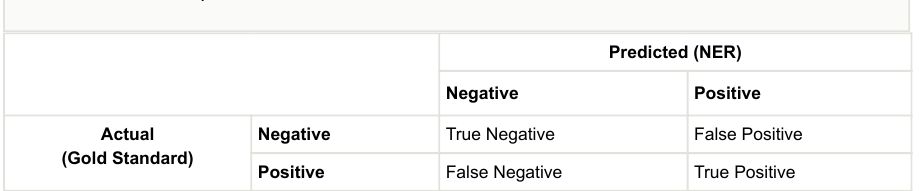
Table 8. Confusion matrix for predicted and actual labels.